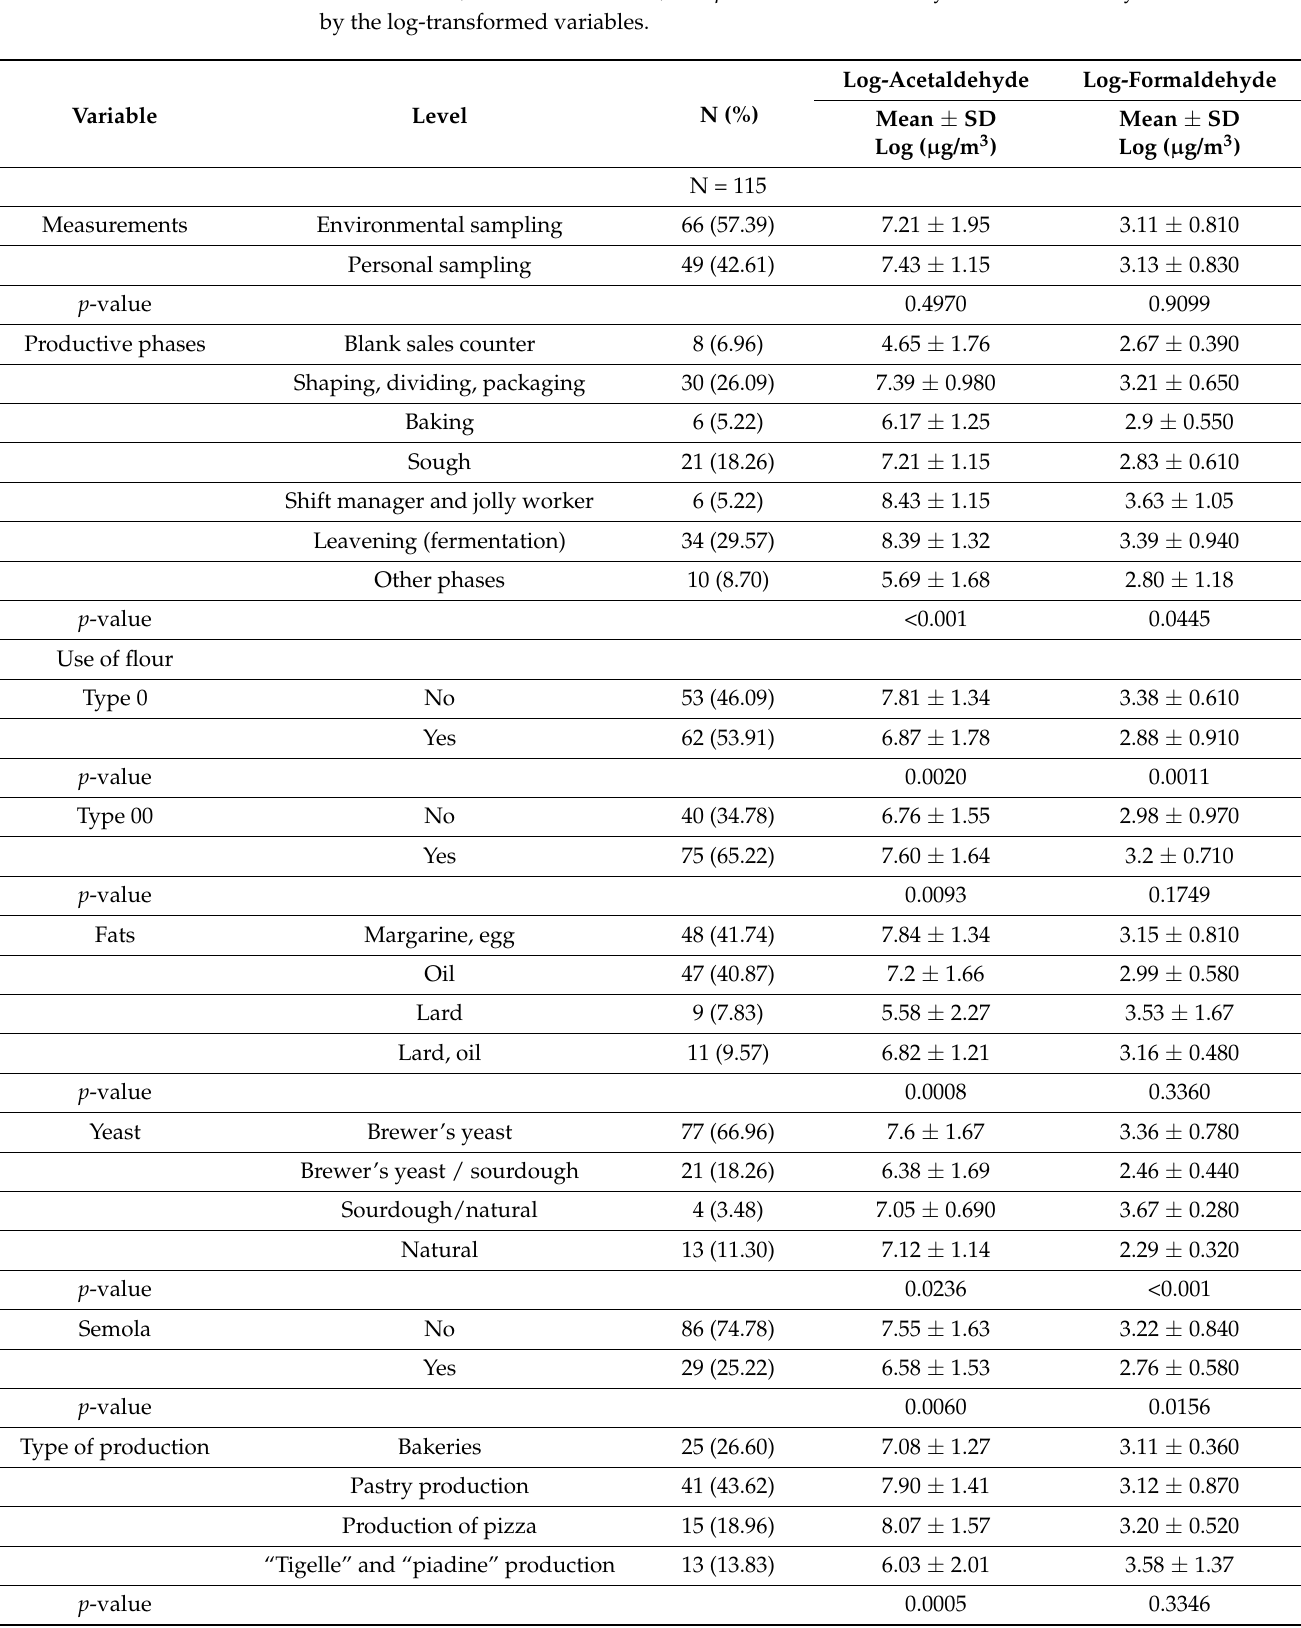
Table 3. Mean, standard deviation, and p -values for acetaldehyde and formaldehyde concentration by the log-transformed